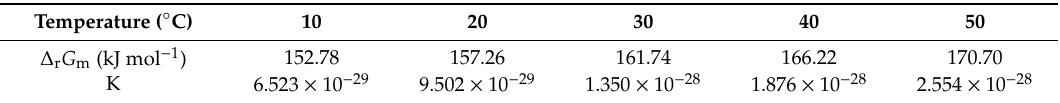
Table 3. Gibbs free energies and corrosion reaction equilibrium constants of aluminum at various